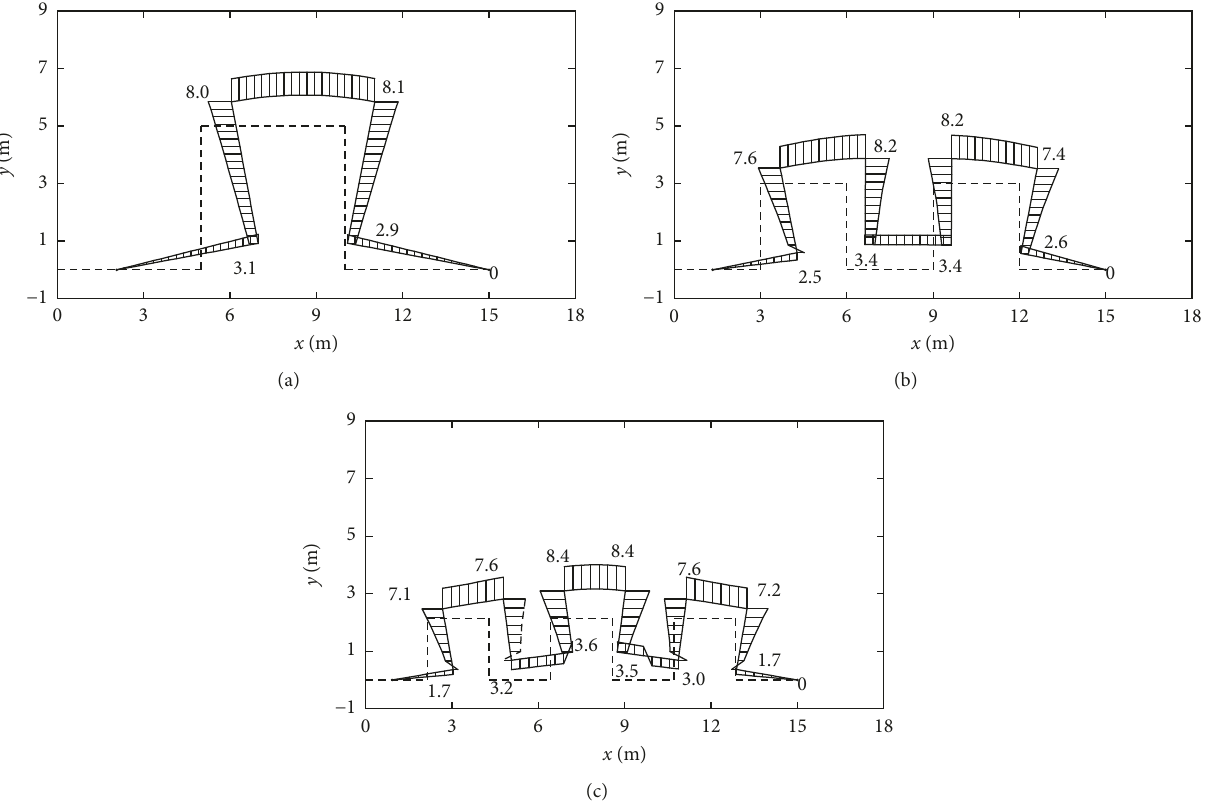
Figure 16: Maximum bending moment diagrams of the structures during impact and deflections of the structures after impact corre- sponding to different beam unit numbers (unit: